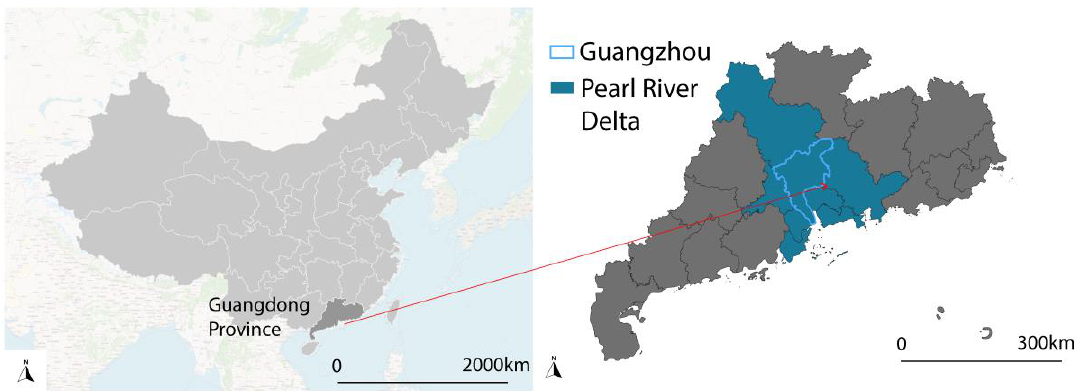
Figure 1. Location of Guangzhou city.